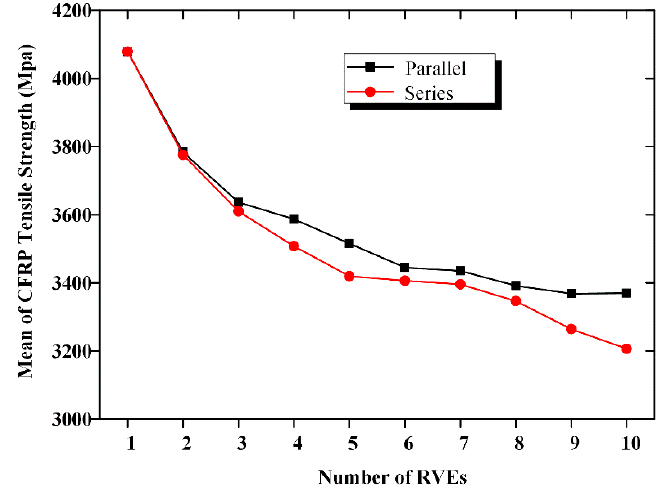
Figure 6. Mean strength of CFRP.